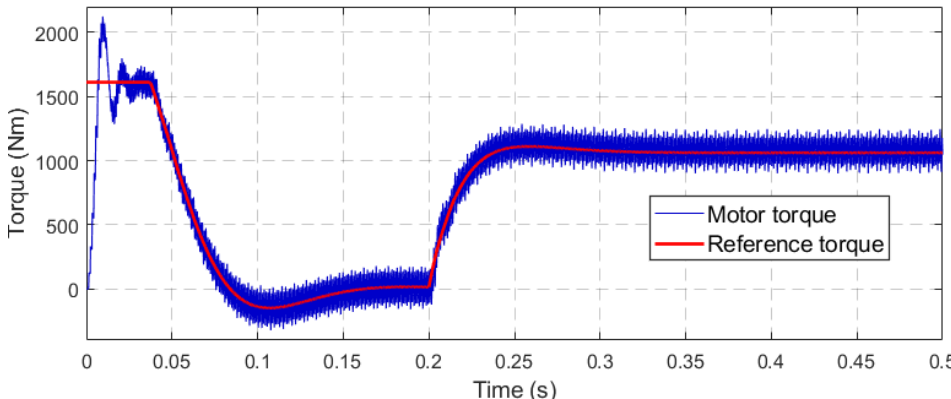
Figure 20. Reference torque and measured torque before and after a rated load torque step is applied at t = 0.2 s.